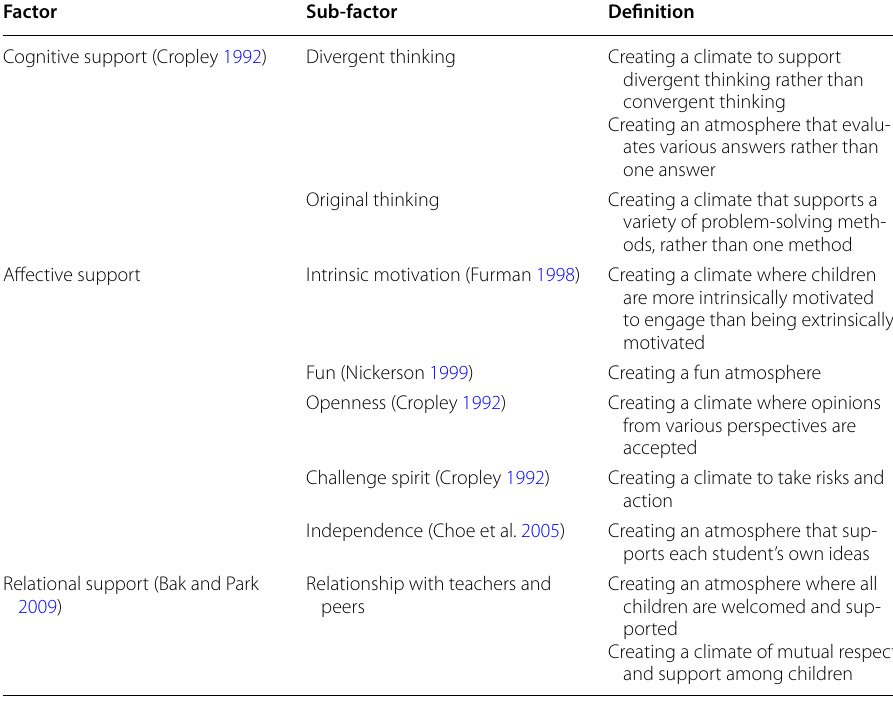
Table 1 Characteristics of creative classroom climate Factor